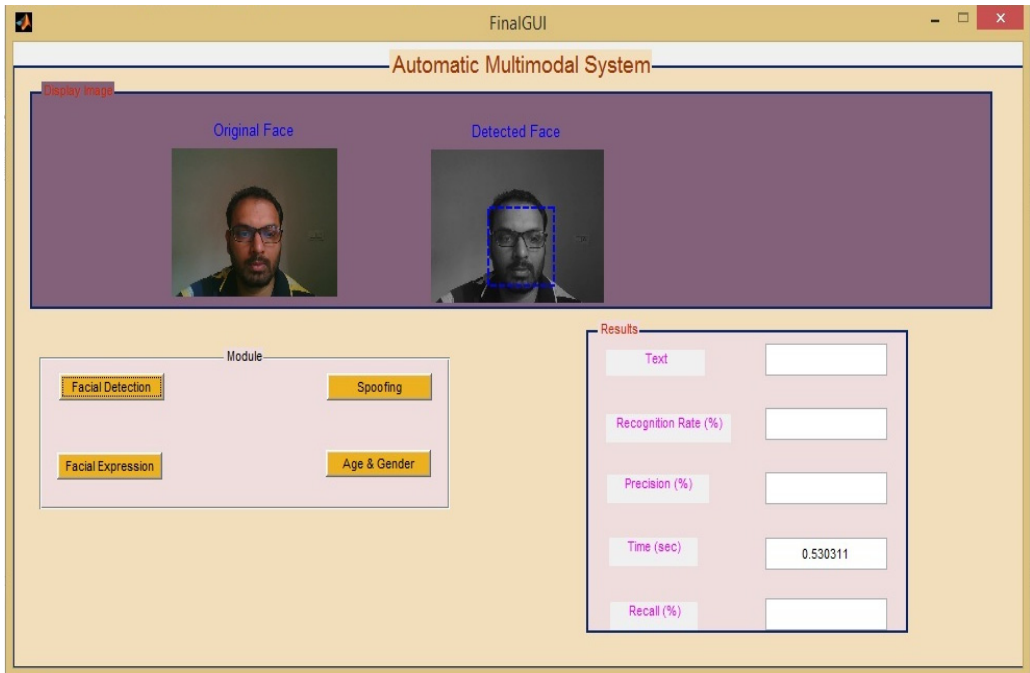
Figure 5. Real-time face detection with the processing time.